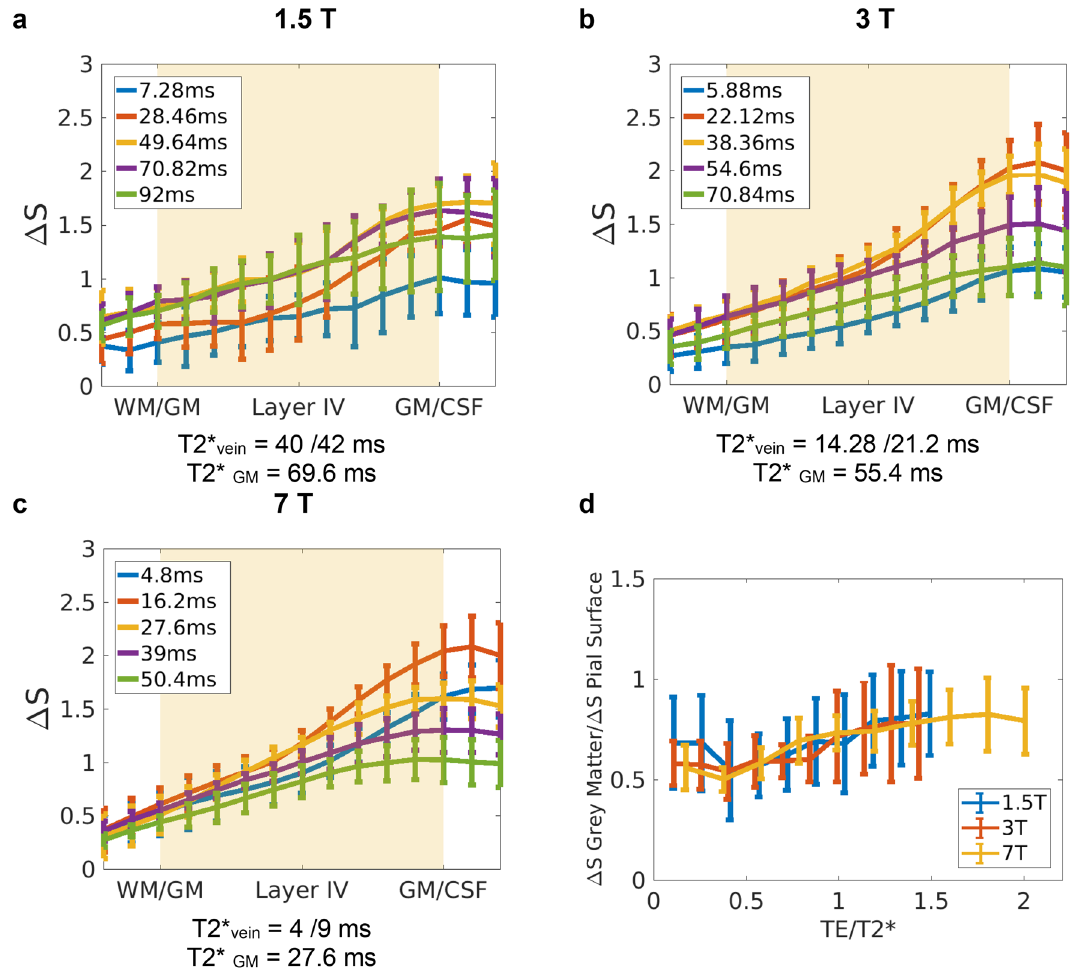
Figure 2. ( a – c ) BOLD signal change, ∆S, profiles averaged over subjects for different echo times (5 out of 10 echo times shown for visualization purposes). at 1.5 T, 3 T and 7 T ( a ), ( b ) and ( c ), respectively. ∆S is normalised to the mean signal change averaged over depth and TE per subject. The individual profiles have been divided by the mean value over echoes and cortex (hence, one value per profile), so that the average profile is not dominated by differences in the mean response between subjects. ( d ) The ratio between the signal change in the middle of the cortex and on the pial surface across fields. The x-axis shows echo times at each of the field strengths normalized by the corresponding T2* in the middle of the cortex. The 2-way ANOVA significance test shows that only the effect of the echo time was significant (p = 0.00). For short echo times (TE1–5), with considerable intravascular contribution, the grey matter to pial ratio is significantly different to that of late echoes (TE8–10), where venous signal has faded away. Resting R2* and ΔR2* upon activation. Transverse relaxation times at rest and upon activation are shown in Fig. 3. The acquisition and analysis approach used in this work (i.e. acquiring at submillimetre iso- tropic resolution and integrating over a given cortical depth) allows for a good separation between cortical signal and signal from the pial surface, as it limits the partial volume effects. The mono-exponential signal decay was a good fit for the signal decay within grey matter. The estimated average T2* relaxation times within the cortex (T2* = 70, 55 and 27 ms approximately, see Table 2) are in line with those published previously (as summarised in SI:Table 3a). The average R2* values and profiles obtained at 7 T are similar to those shown in 43 . The reduction in R2* from the WM to the pial surface (Fig. 3a–c) was observed at all field strengths and has been attributed to a combination of reduced myelin and iron 44 . On the other hand, the variation in transverse relaxation rate upon activation, ΔR2*, showed the opposite behaviour, increasing from the WM to the pial surface, reflecting the increased blood partial volume and oxygenated blood draining towards the cortical surface. The voxels that coincide with the pial surface generated in FreeSurfer will in general contain three compart- ments with very different relaxation times: grey matter, CSF and pial veins. The mono-exponential fit to this